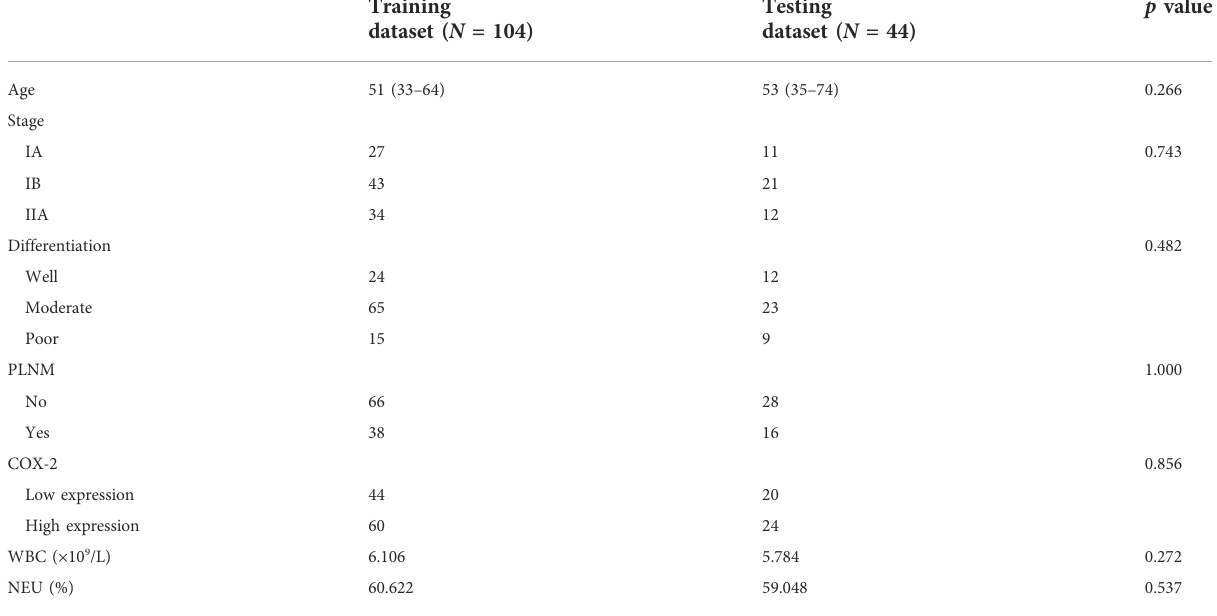
TABLE 1 Patient